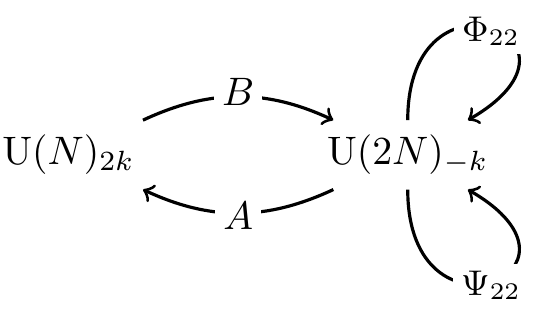
Figure 2 . Quiver for Laufer’s 3d